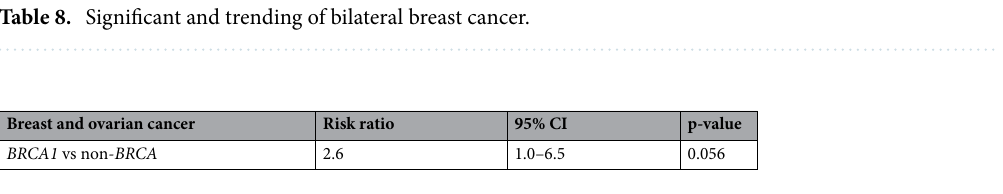
Table 9. Significant and trending of breast and ovarian